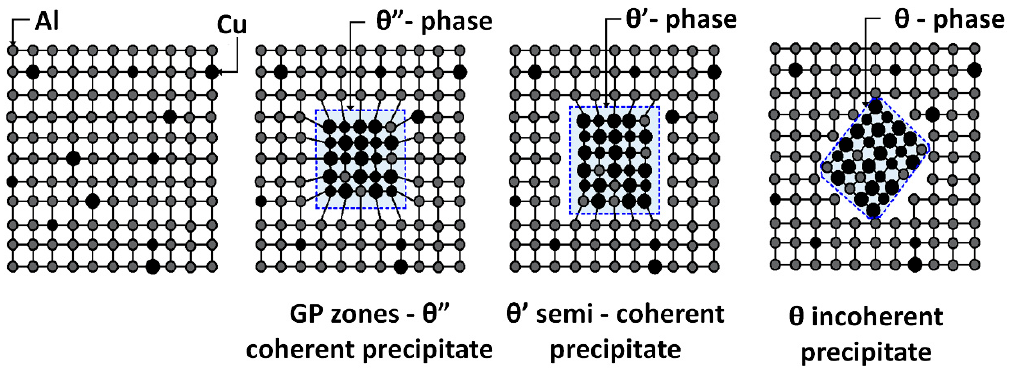
Figure 1. Schematic representation of the precipitation process [7].